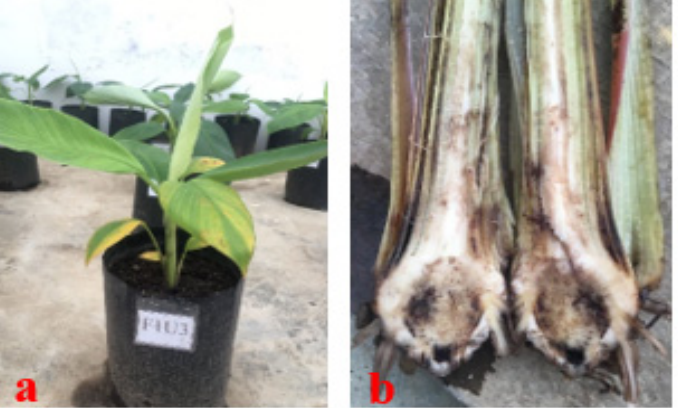
Figure 4. Koch’s postulate test ( a ) External Symptoms ( b ) Internal Symptoms.